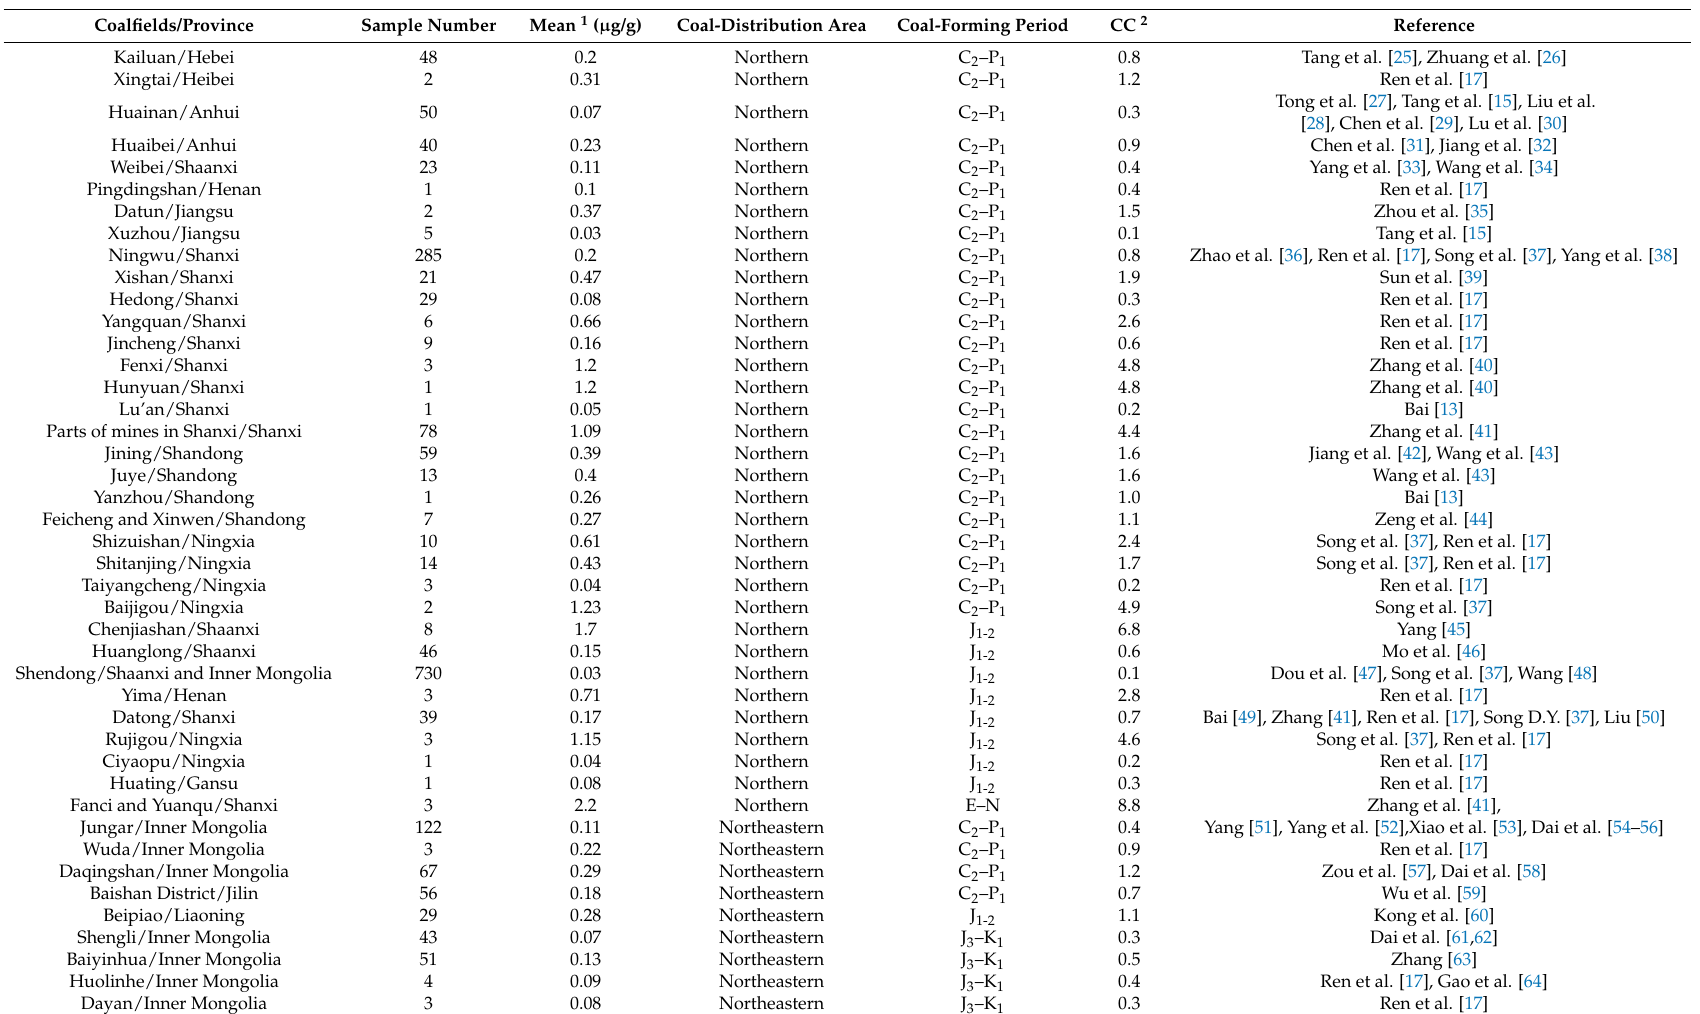
Table 2. Cadmium concentration in coals of